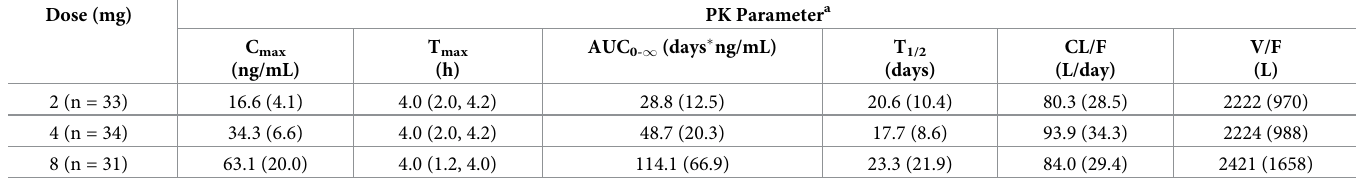
Table 2. Summary of PK parameters of moxidectin for dose levels studied. Dose